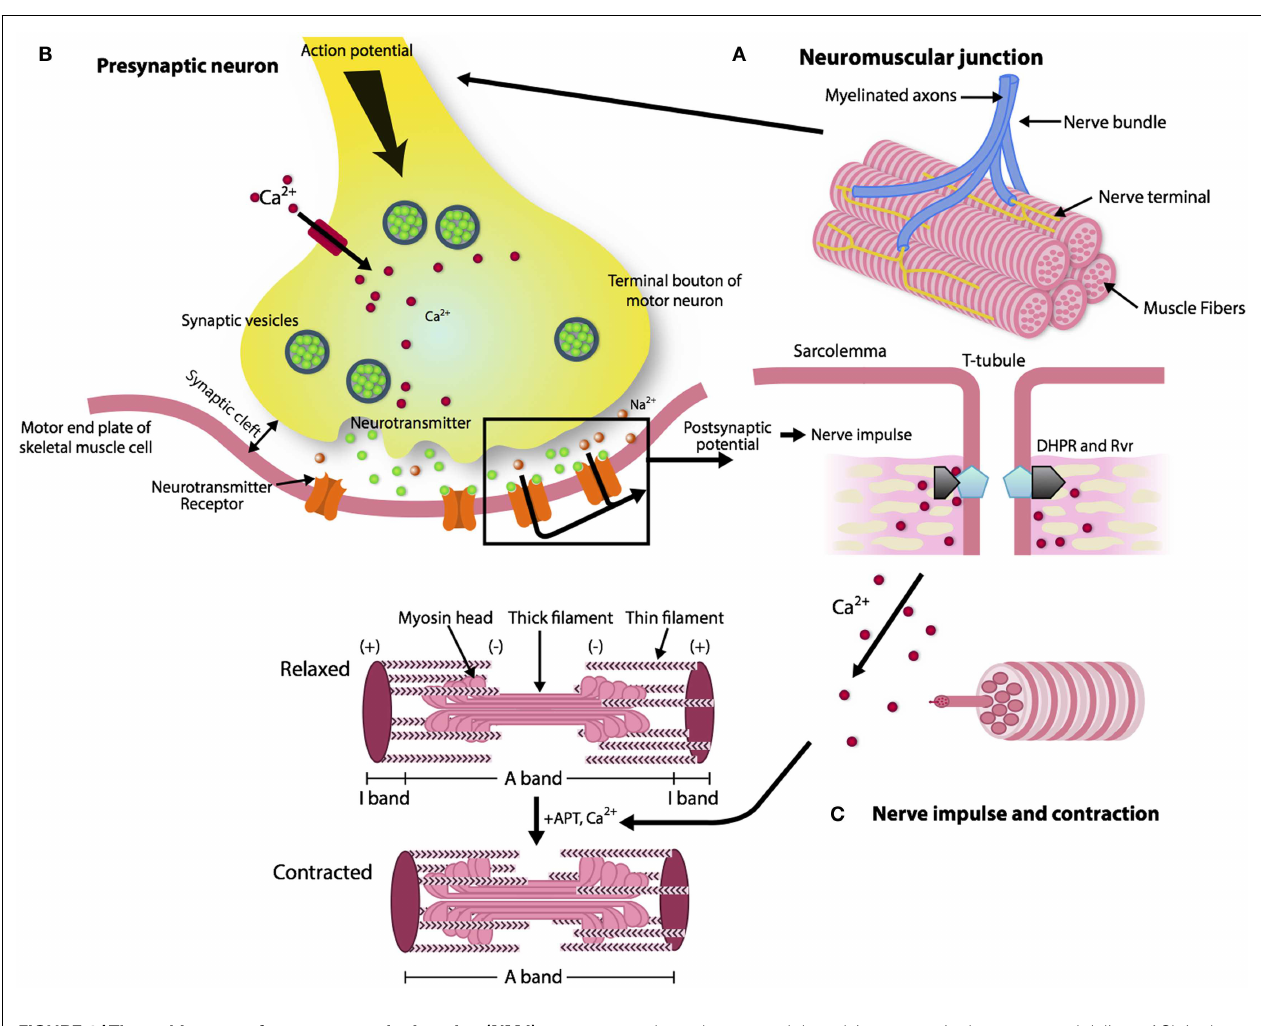
FIGURE 1 |The architecture of a neuromuscular junction (NMJ) . (A, B) The NMJ is composed of three elements: pre-synaptic (motor nerve terminal), intrasynaptic (synaptic basal lamina), and post-synaptic component (muscle fiber and muscle membrane) (Punga and Ruegg, 2012). When the action potential reaches the motor nerve terminal the calcium